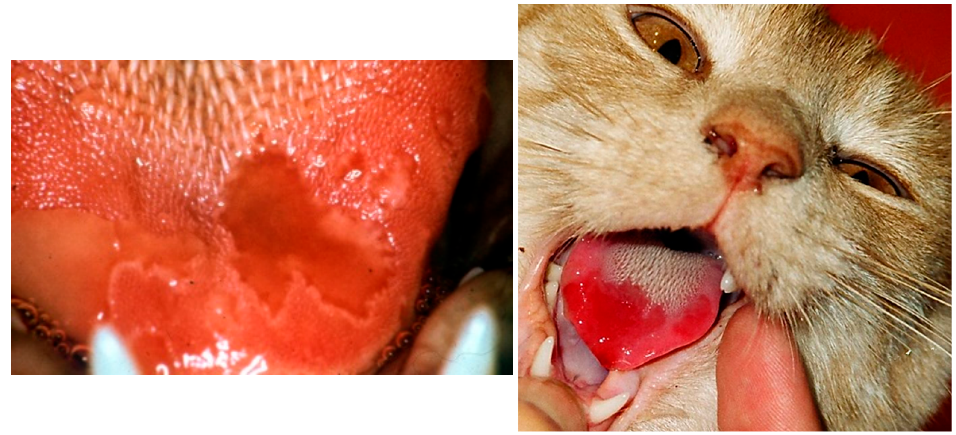
Figure 4. Ulcerative lesions on the tongue of cats with FCV infection. Left, ©Marian C. Horzinek; right, ©Tadeusz Frymus.